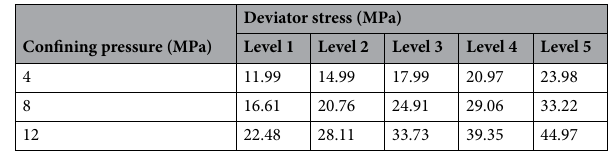
Table 1. The levels of deviator stress during the test.